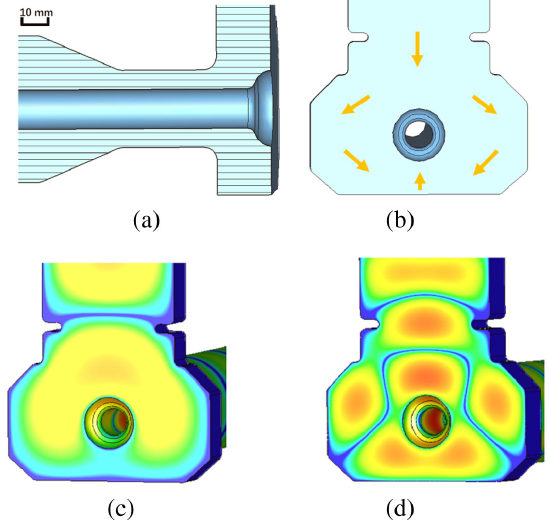
FIG. 4. The geometry of the mode launcher with detail, and the field distribution within the mode launcher once excited. (a) Cross section (b) Launcher box (c) Excited by S-band (d) Excited by